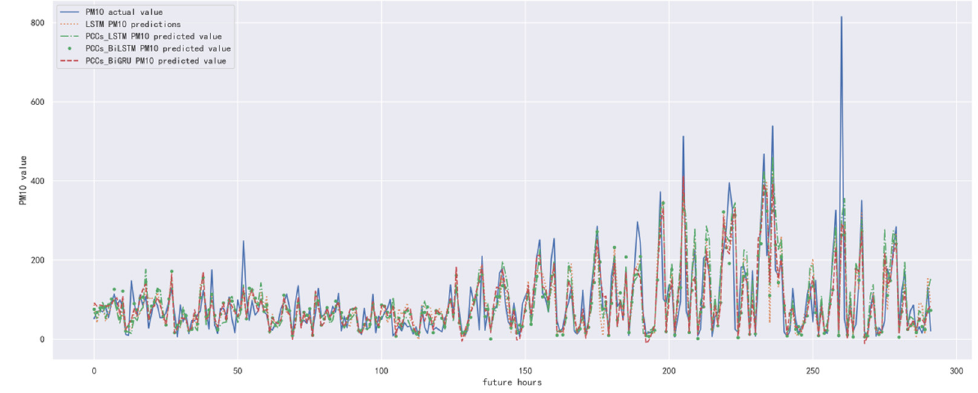
Figure 20. The schematic diagram of predicted PM 10 concentration in the next five hours.